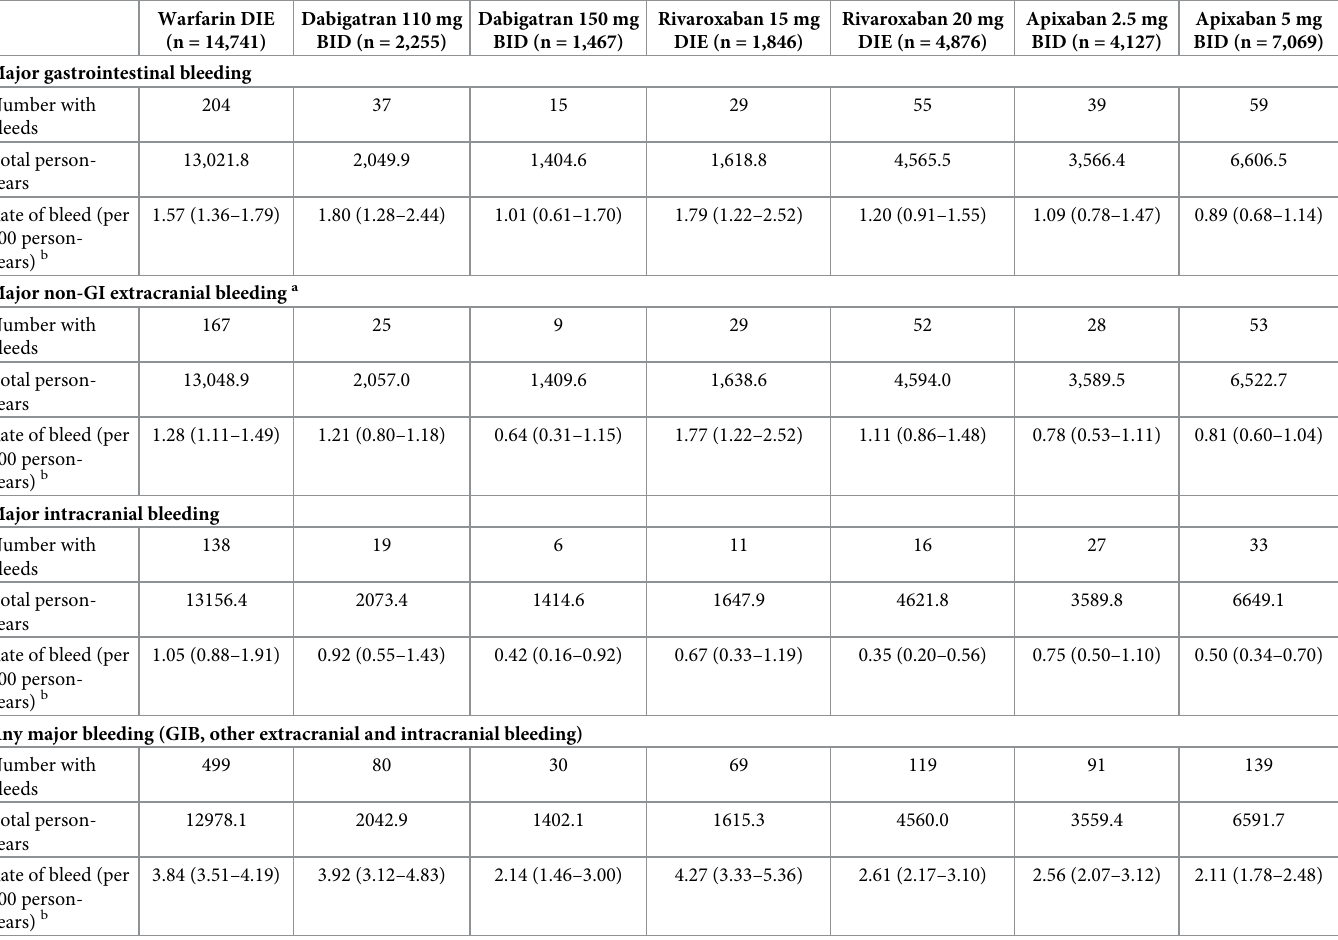
a Non-GI extracranial bleeding includes vitreous, urogenital, hemoperitoneal and unspecified bleeding as well as hemoarthrosis, hemopericardium, hemoptysis, hematuria and post-bleeding anemia. b Incidence rate estimates are followed by exact Poisson 95% confidence